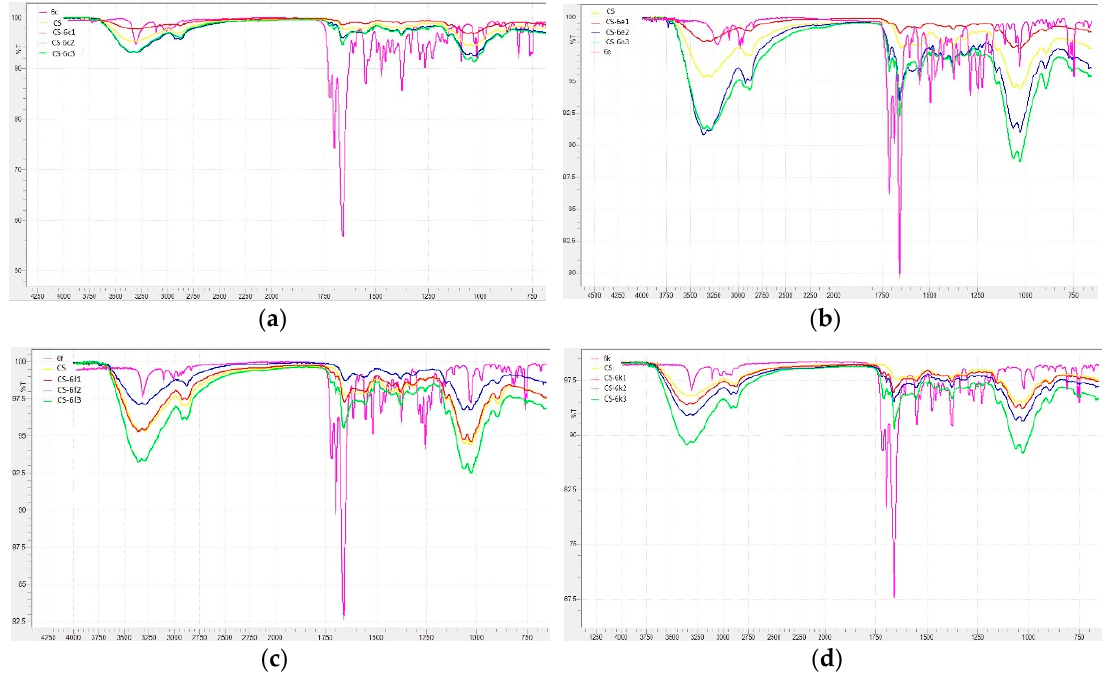
Figure 11. The Fourier transform infrared (FTIR) spectra of CS, XTDs (6c, 6e, 6f, 6k) and CS-XTDs (CS-6c, CS-6e, CS-6f, CS-6k) ( 1 = 3 mg/mL, 2 = 4 mg/mL, 3 = 5 mg/mL).